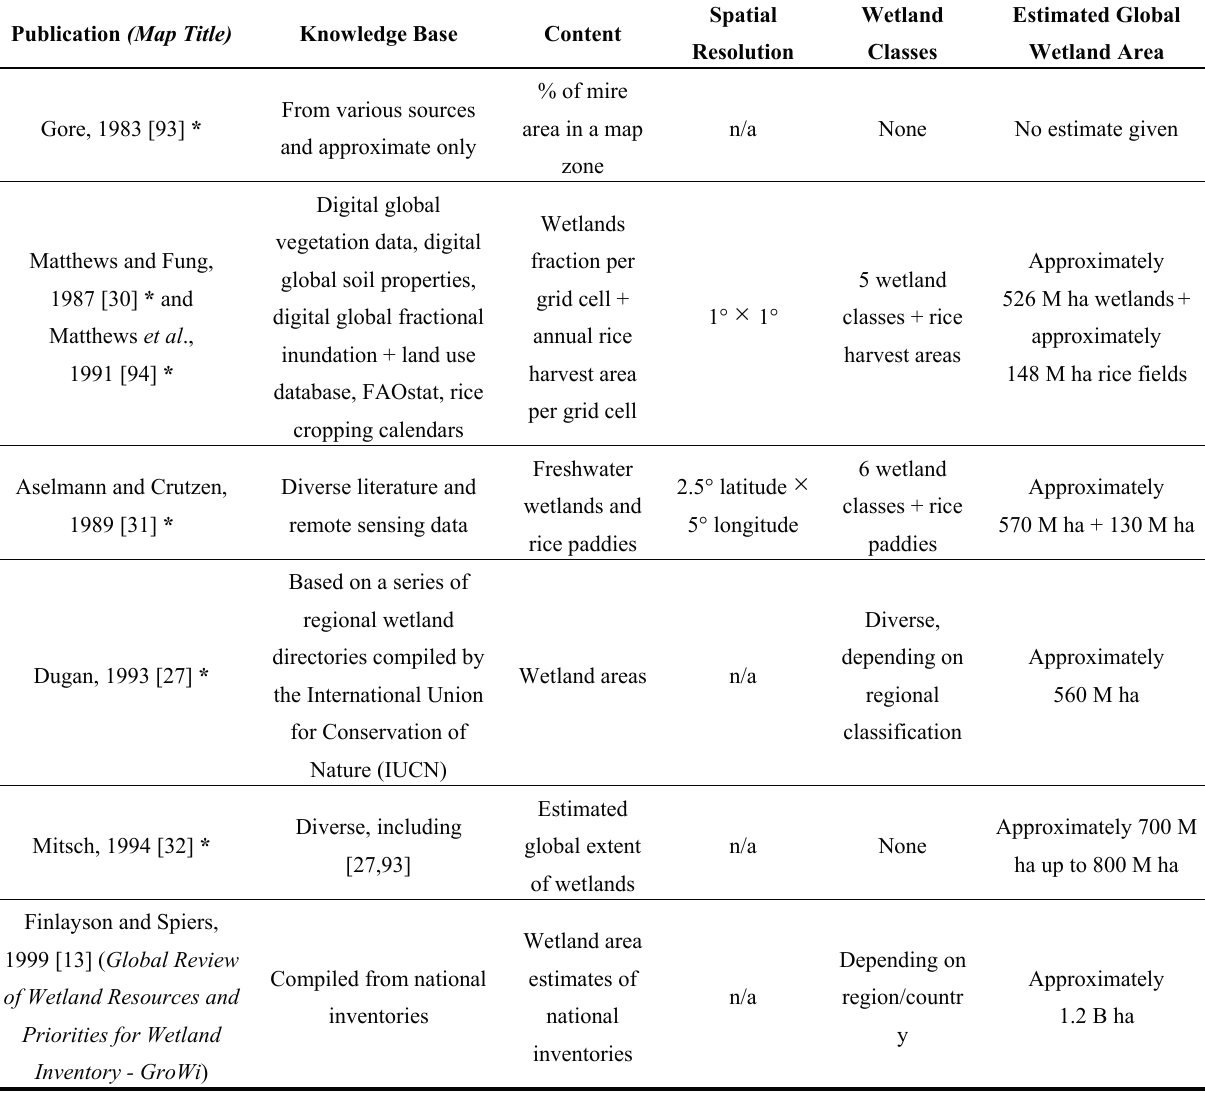
Table 4. Compilation of global wetland